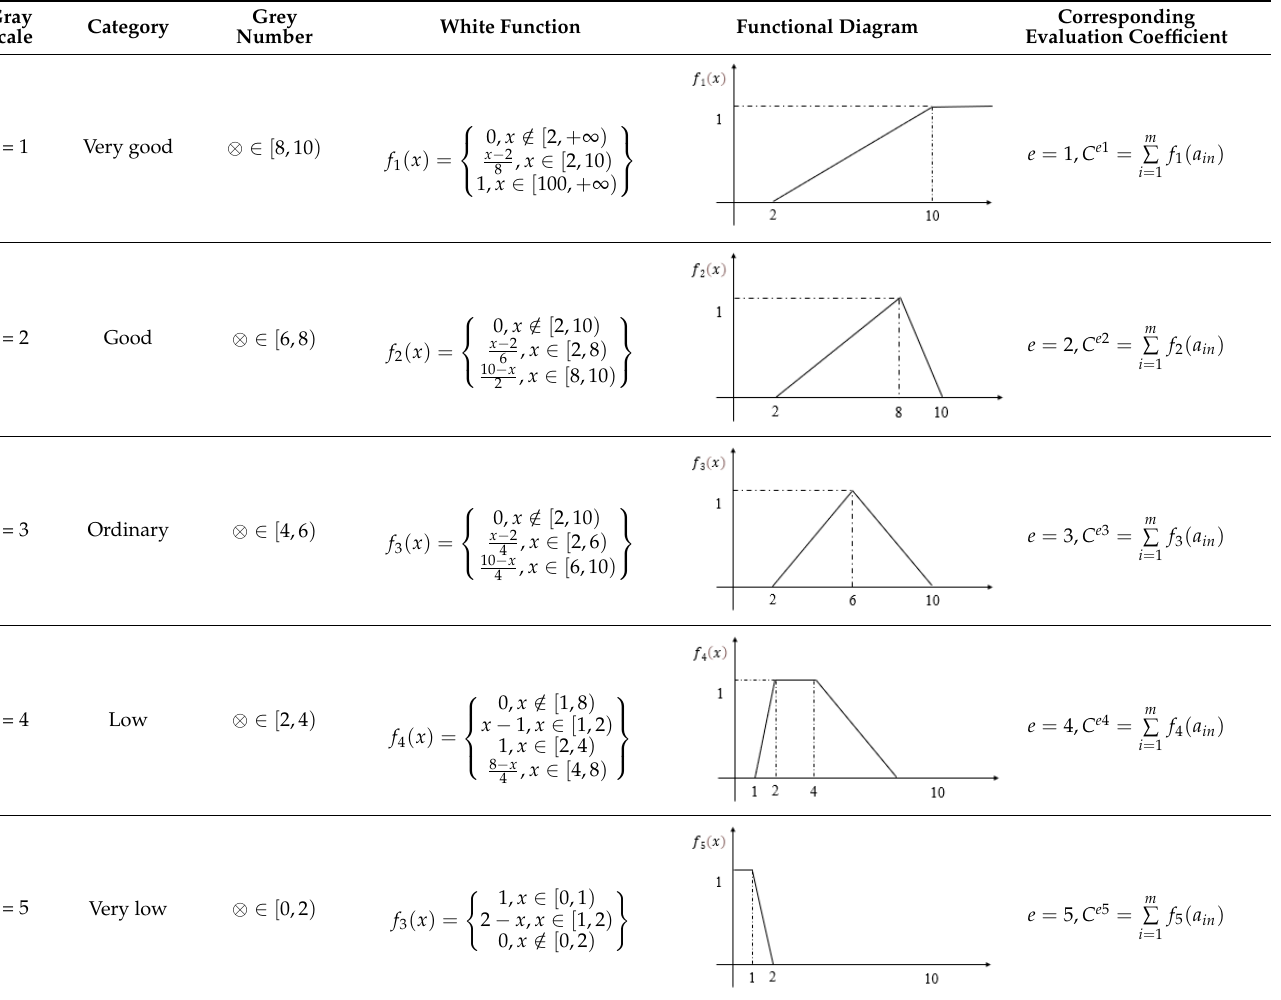
Functional Diagram